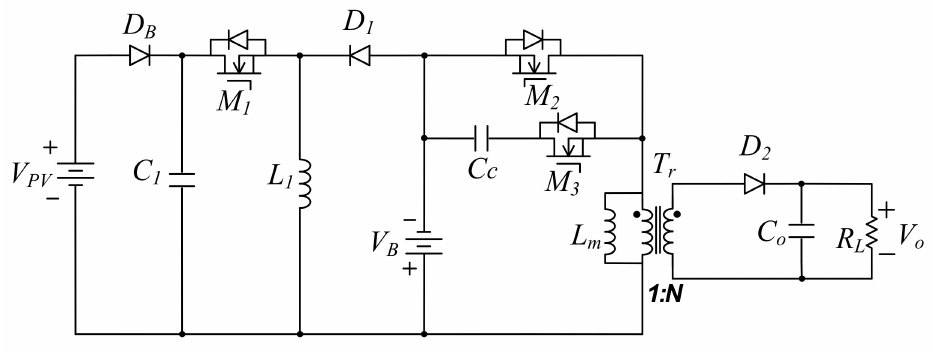
Figure 4. Schematic diagram of buck-boost/flyback converter with active clamp circuit for solar power applications.